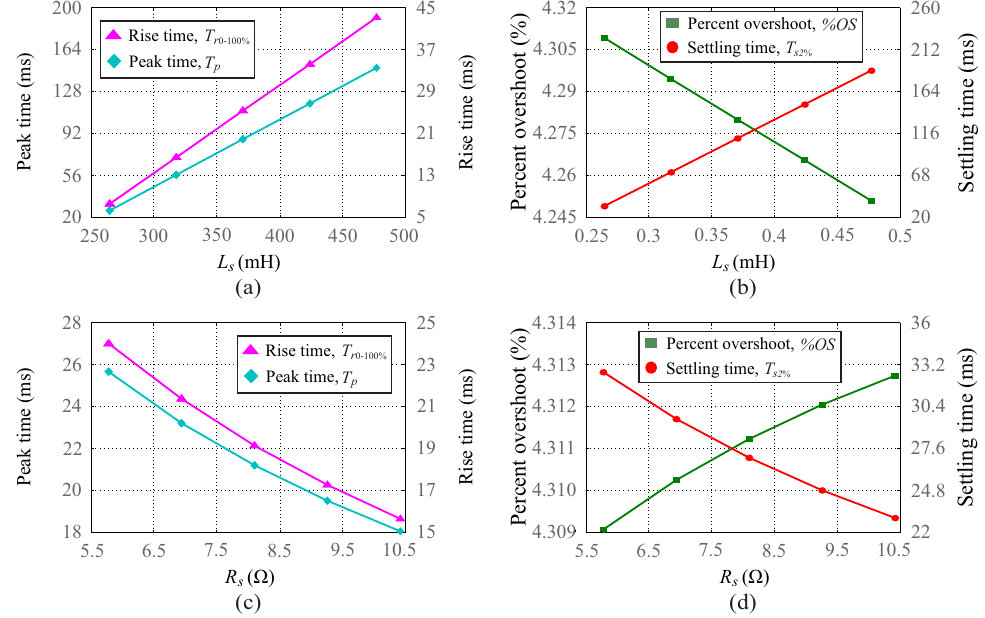
Figure 6. Speed transient response specifications for armature winding parameter variations. ( a ) Rise time and peak time for L s variations. ( b ) Percent overshoot and settling time for L s variations. ( c ) Rise time and peak time for R s variations. ( d ) Percent overshoot and settling time for R s